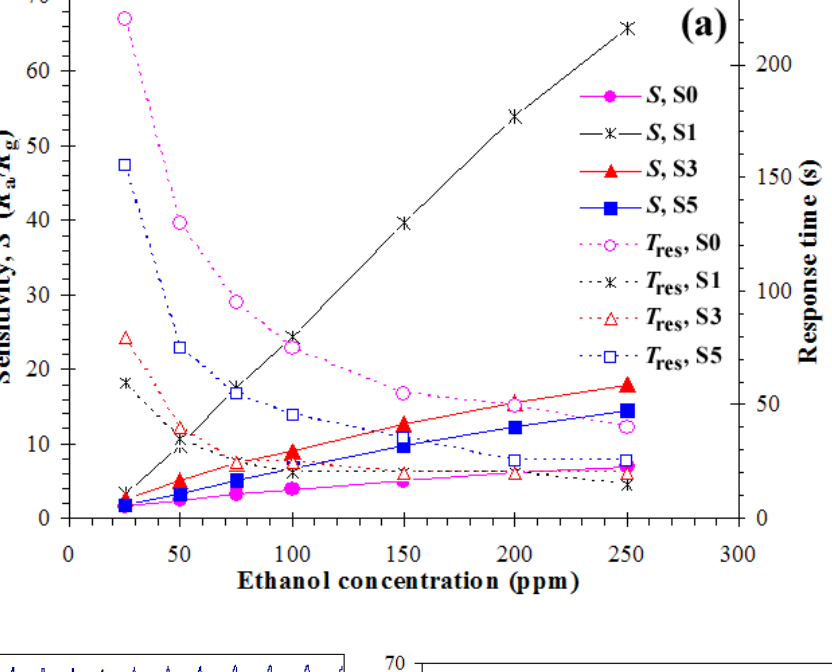
Figure 11. (a) Sensitivity of S0, S1, S3, and S5 (solid line, left axis) and the corresponding response time (dashed line, right axis), (b) Change in resistance of sensor S1 under exposure to reducing gas ethanol during forward (triangles) and backward (rectangles) cycle and sensitivity (left axis) dependence on ethanol concentration (c) in dry air O right axis) were within seconds, recovery times within a few minutes ( T